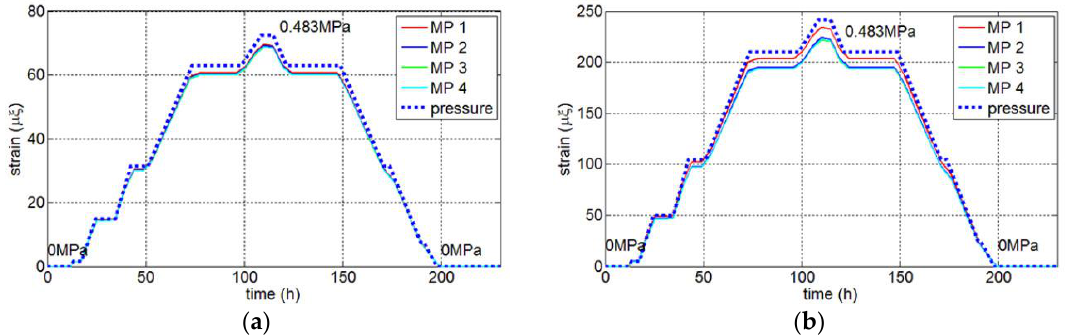
Figure 12. The calculation results in two directions. ( a ) Vertical direction strain; ( b ) Circumferential direction